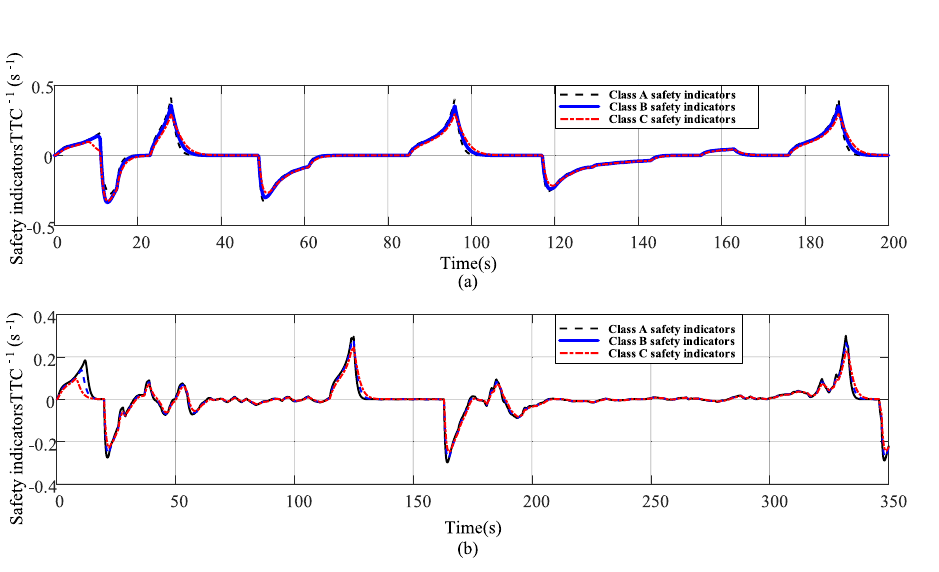
Figure 12. ( a ) The three types of driver following safety indicators for the standard working condition ECE. ( b ) Three types of driver following safety indicators corresponding to the standard working condition